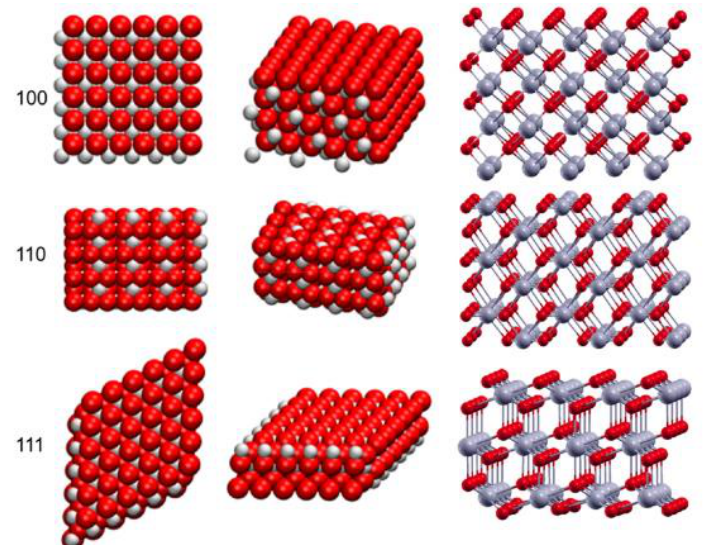
Figure 14. Top, side and perspective view of CeO 2 (100), (110) and (111) surfaces. Gray and red spheres represent Ce and O ions, respectively. Reproduced with permission from Ref. [85]. Copy- right© 2017, American Chemical Society.